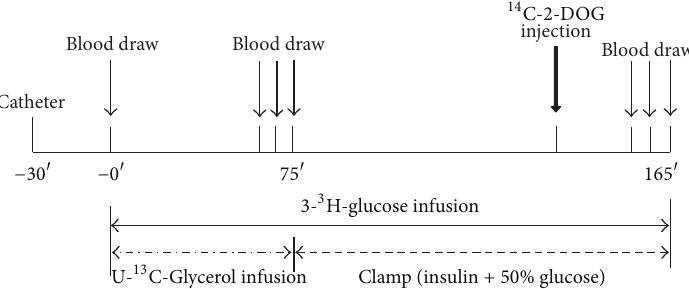
Figure 2: Schematic diagram of the tracer infusion protocol. The process of blood collection and tracer infusion from beginning to end.